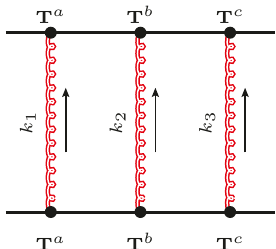
Figure 2. A two-loop diagram representing the leading contribution to the amplitude due to triple Reggeon exchange. Note that the diagram drawn is just one of the six distinct orderings in eq.